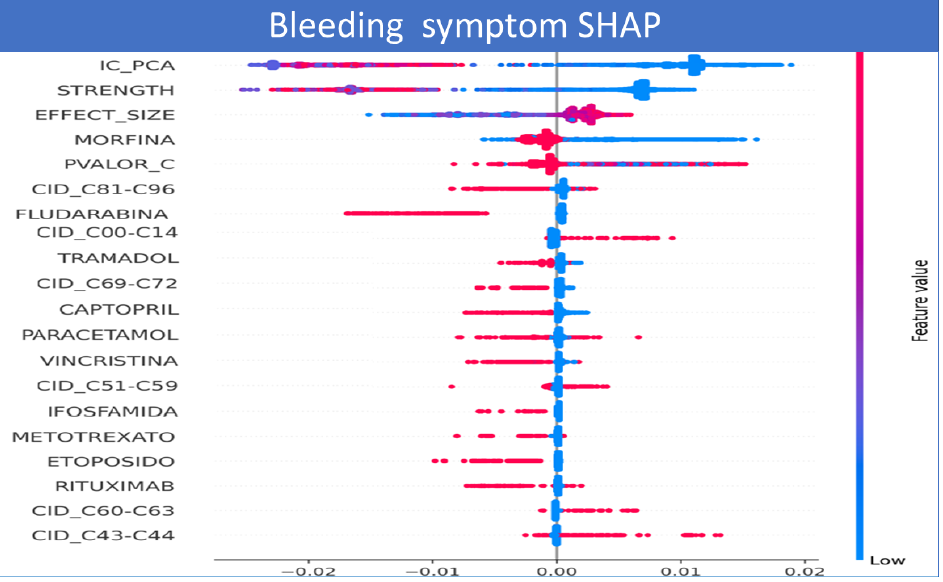
Figure 18. SHAP value